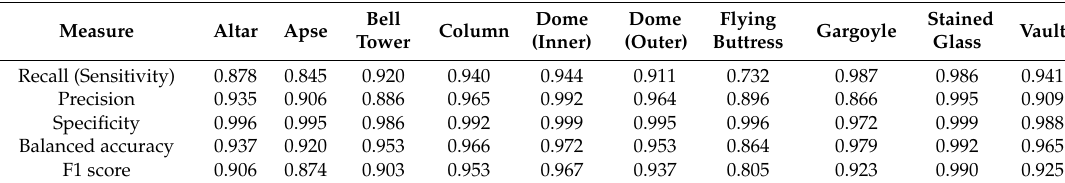
Table 8. Different metrics of the results obtained in each class using a ResNet network (full-training) and the validation dataset.